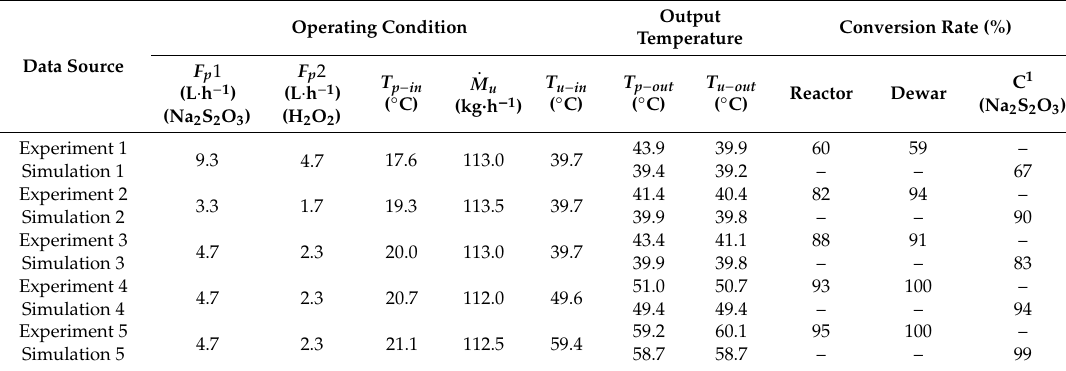
Table 3. Comparisons of experiment and simulation data with reaction.